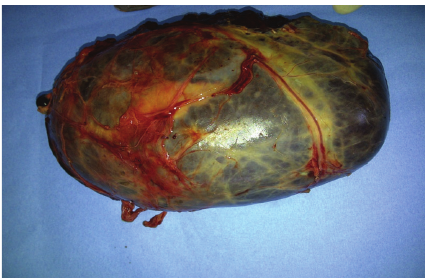
Figure 1: A 20 cm right suprarenal accessory spleen removed.